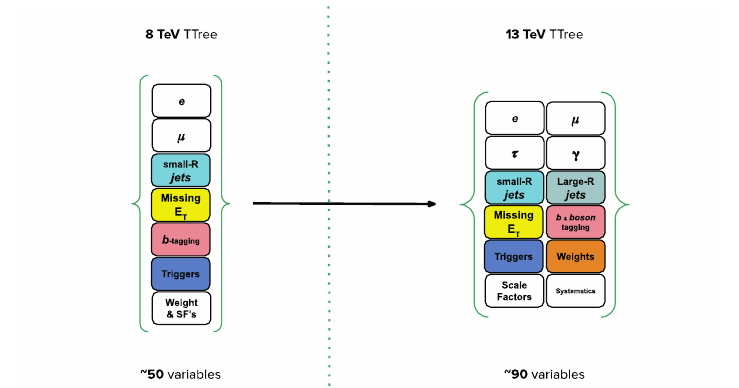
Figure 3. Evolution of ATLAS Open Data tuple structure from the 8 TeV release (2016) to the 13 TeV release (2019/2020).